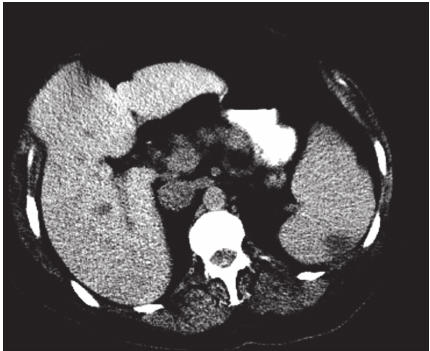
Figure 2: Image depicting desquamating vesiculobullous lesions of the feet.